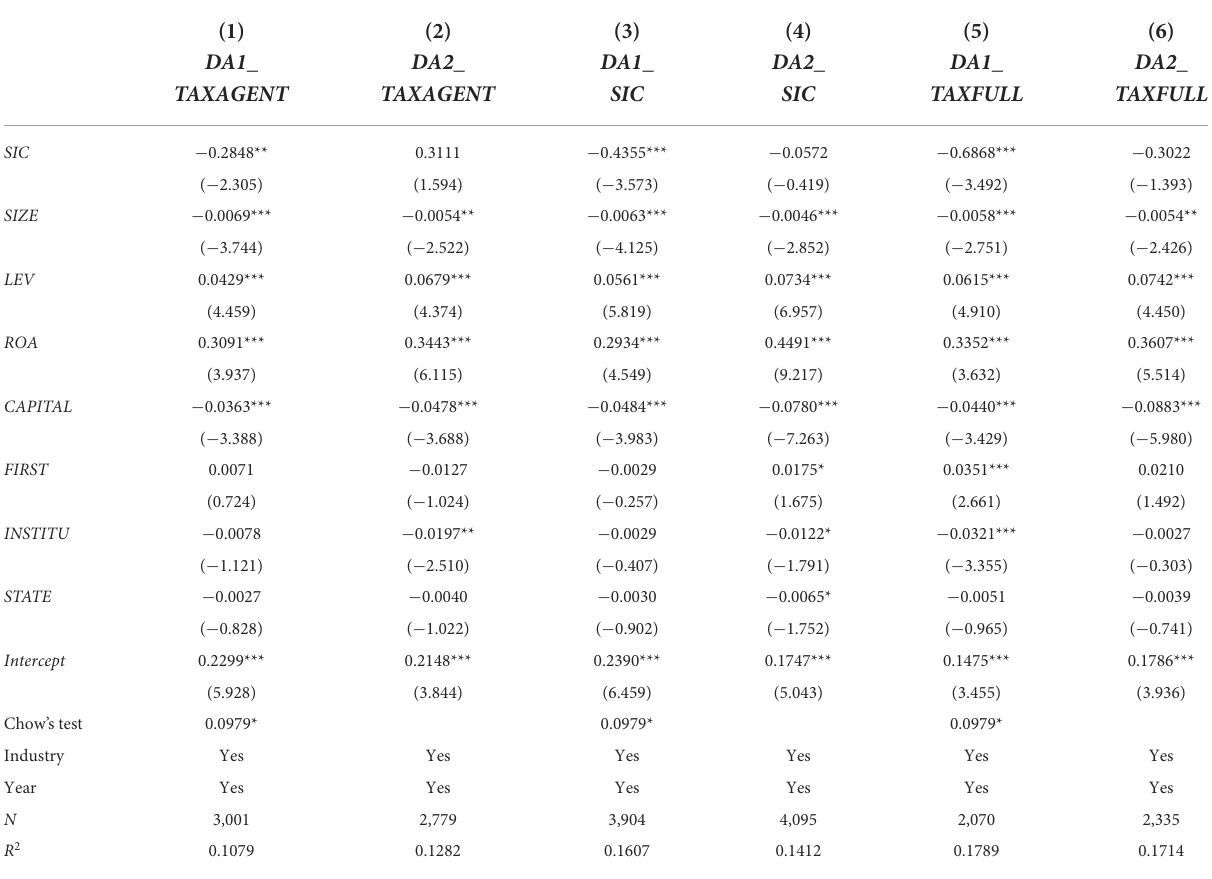
TABLE 15 Tax avoidance and social insurance contributions